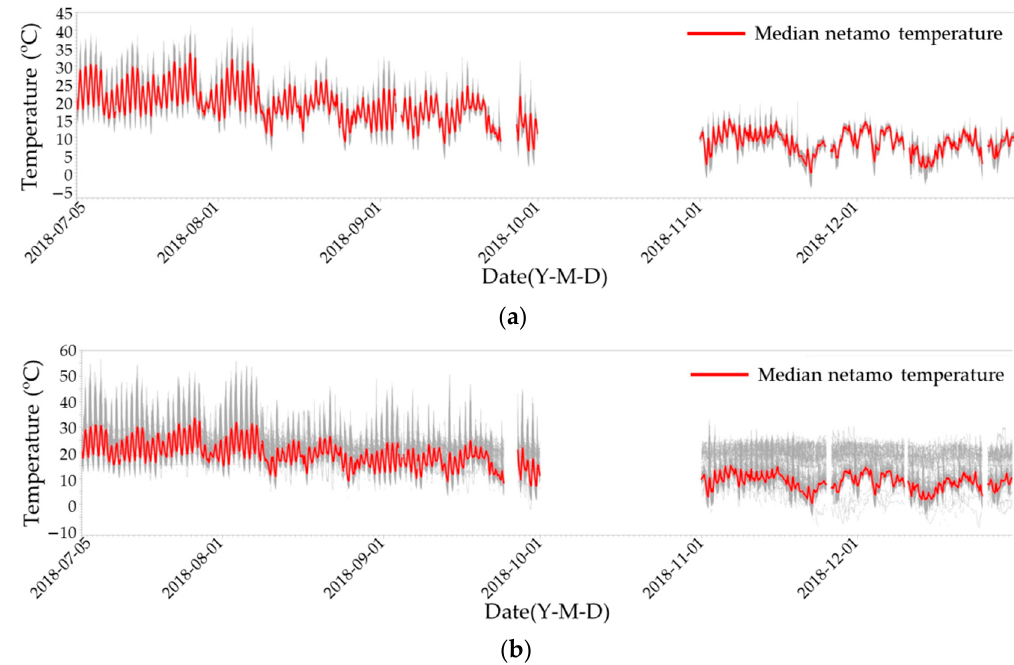
Figure 4. Hourly temperatures over the study period for all Netatmo stations ( a ) and stations that passed the O3 level of the quality check ( b ). Grey lines are a time series for each station and the red line represents the median of the stations.